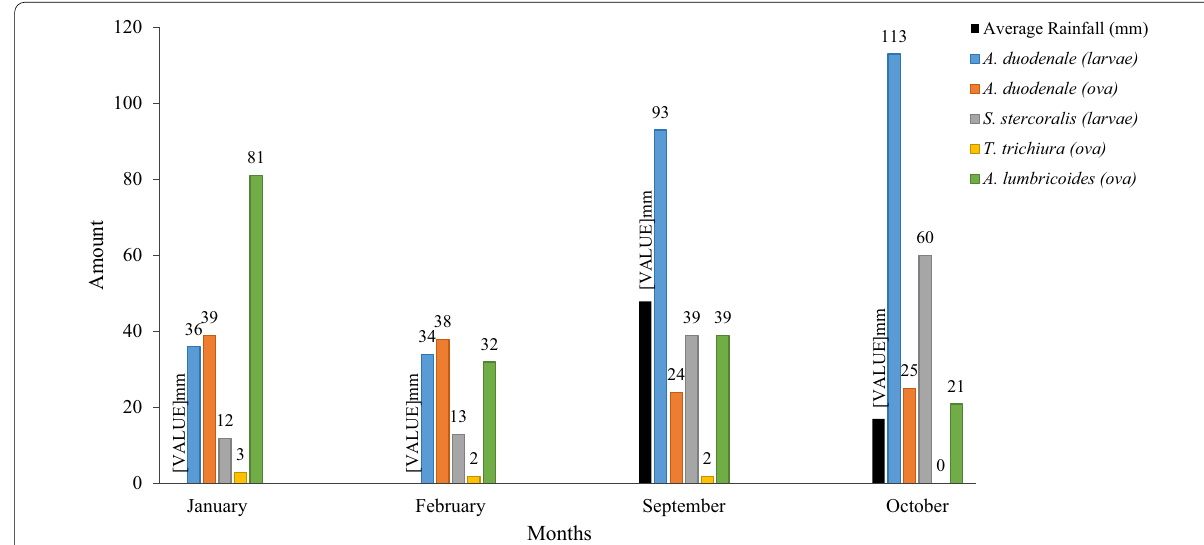
Fig. 2 Relationship between the occurrence of soil‑transmitted helminths and months of